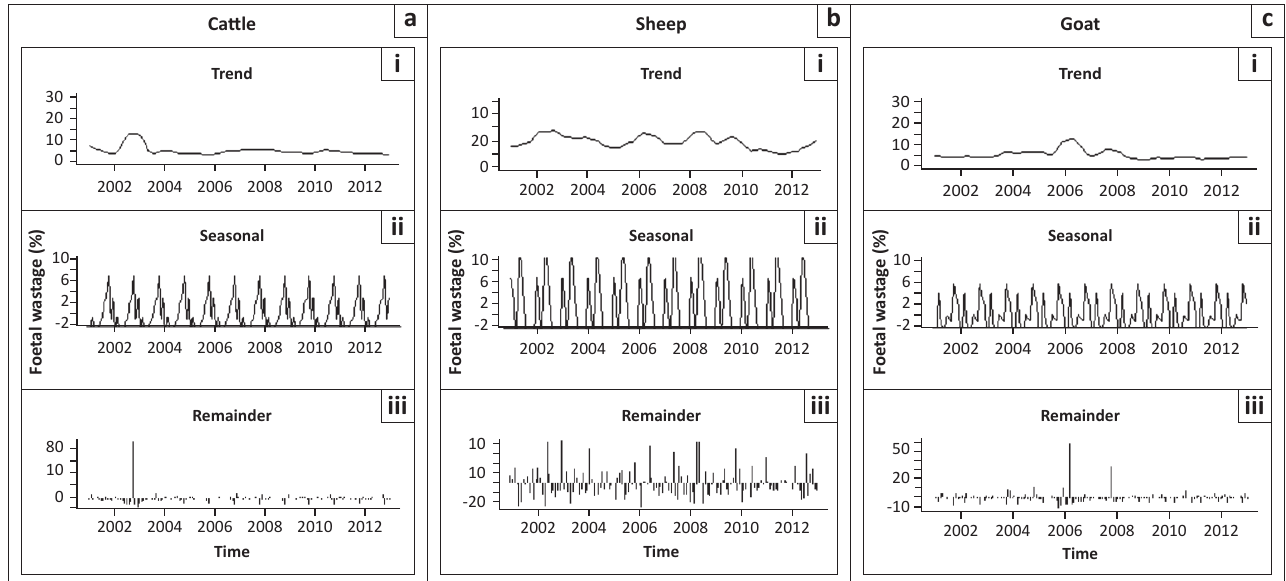
FIGURE 3: Seasonal-trend decomposition of monthly rates of slaughter and foetal wastage at the Minna Metropolitan Abattoir, Nigeria, for the period 2001–2012. (a) Cattle, (b) Sheep and (c) Goats.